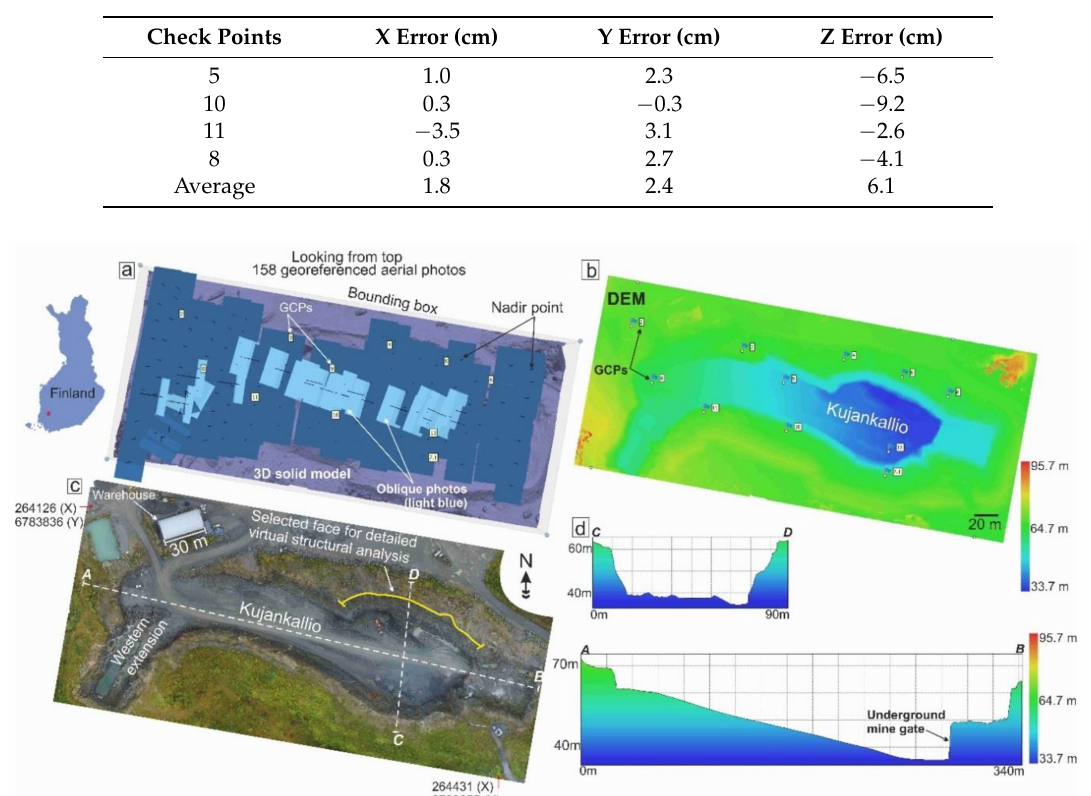
Table 2. Errors in X (easting), Y (northing), and Z (altitude) along check points.